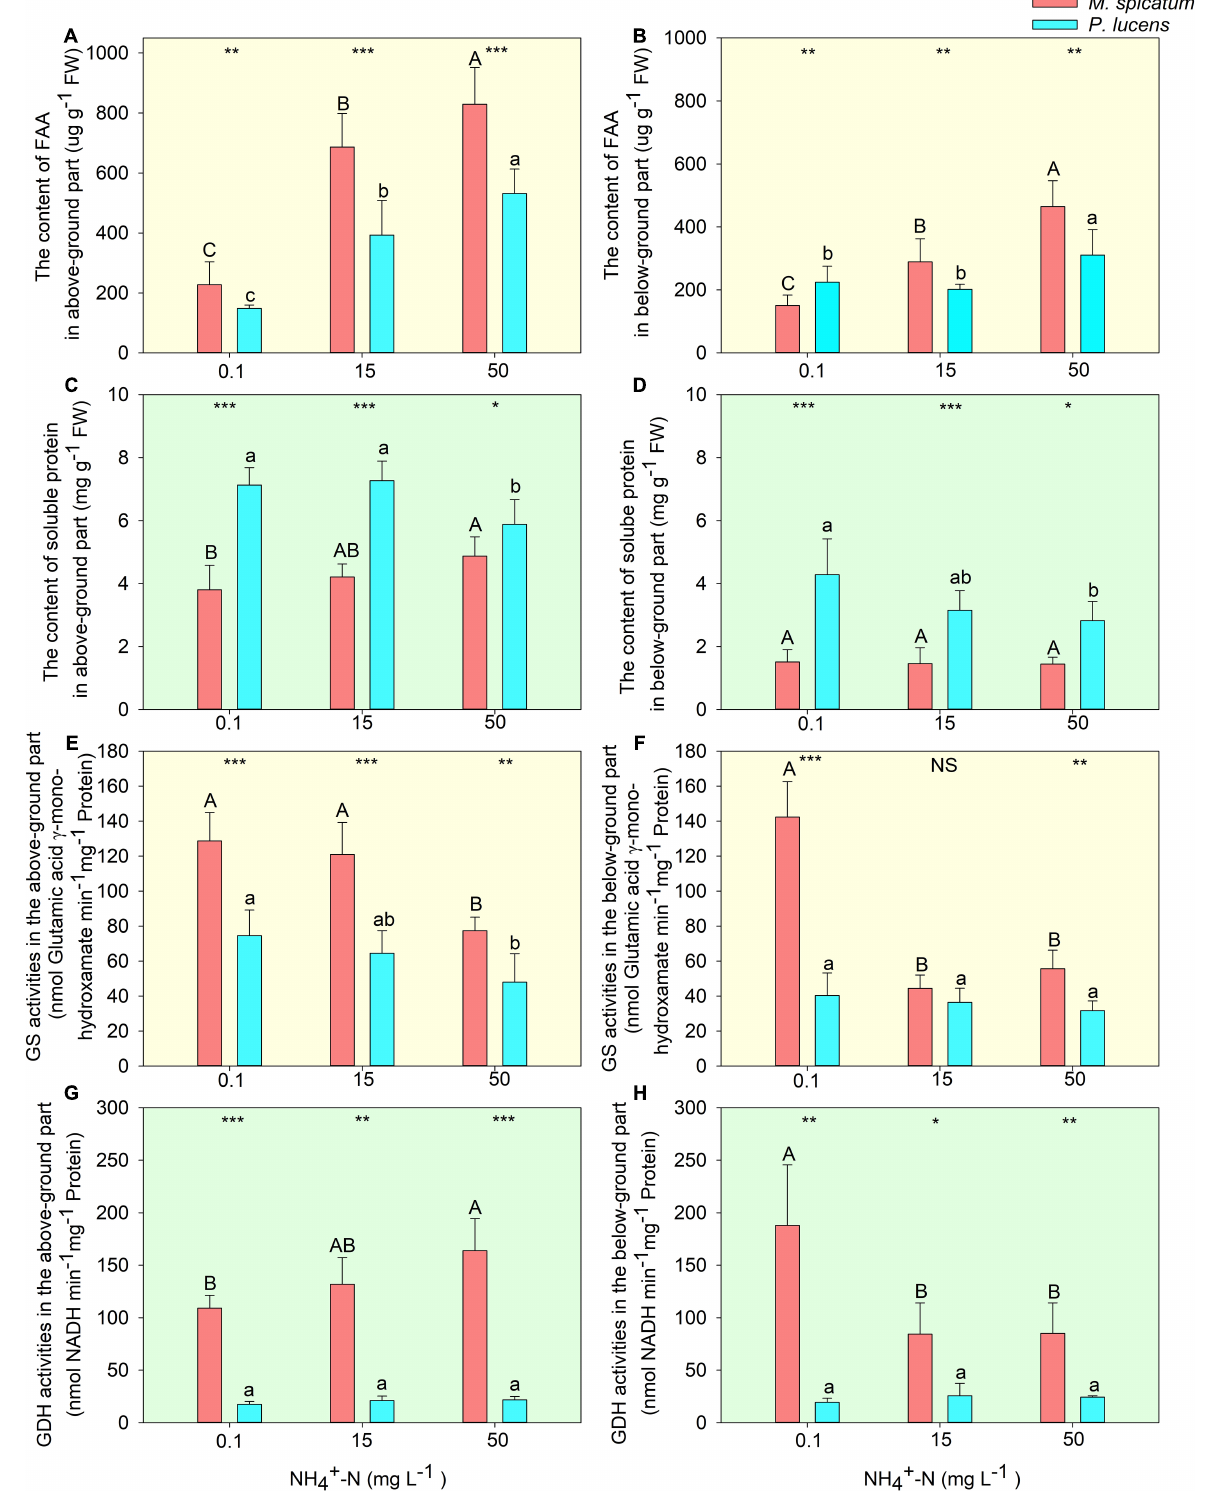
Frontiers in Plant Science |